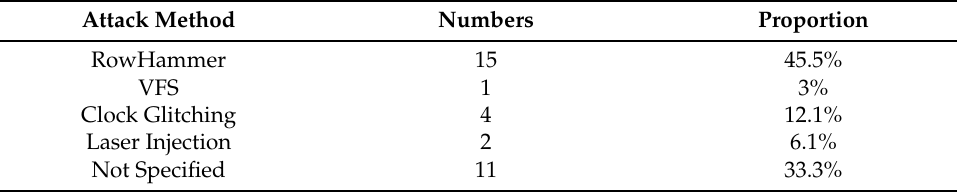
Table 1. Statistics of bit-flip attack methods in recent related works.